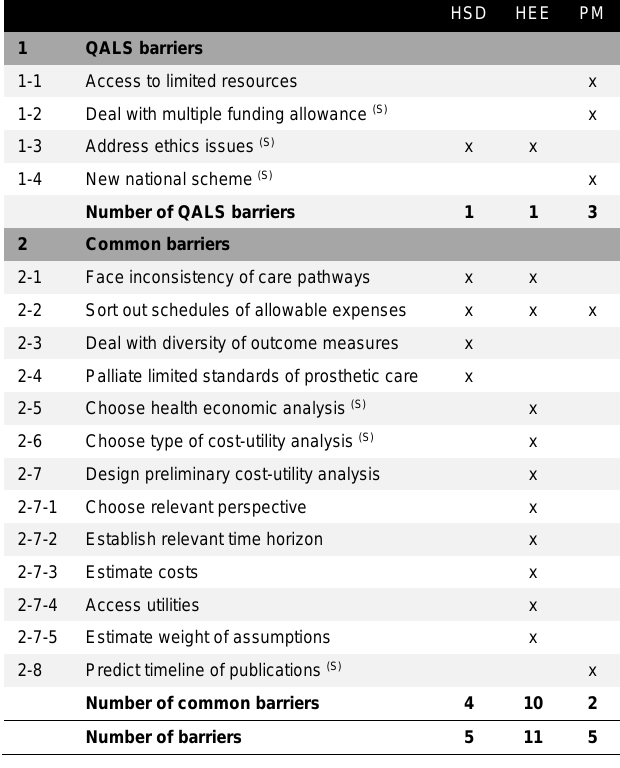
Table 4: List of common and QALS barriers related to health service delivery (HSD) and/or health economic evaluation (HEE) and/or project management (PM) encountered during research focusing on the provision of lower limb bone-anchored prostheses (BAP) led by the Queensland Artificial Limb Service (QALS). ((S): Detailed description to be published in a Data In